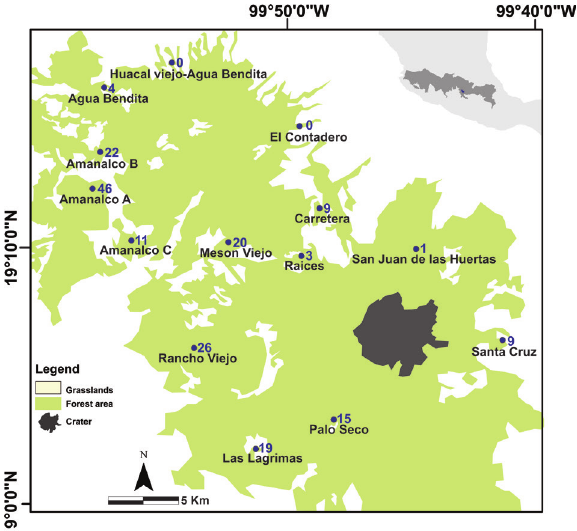
Figure 1. Locations of the 14 study sites in the Nevado de To- luca Volcano, located in the Trans-Mexican Volcanic Belt (dark- grey on the inset map), Mexico. The blue number are the P. robertsi individuals found in each sampling